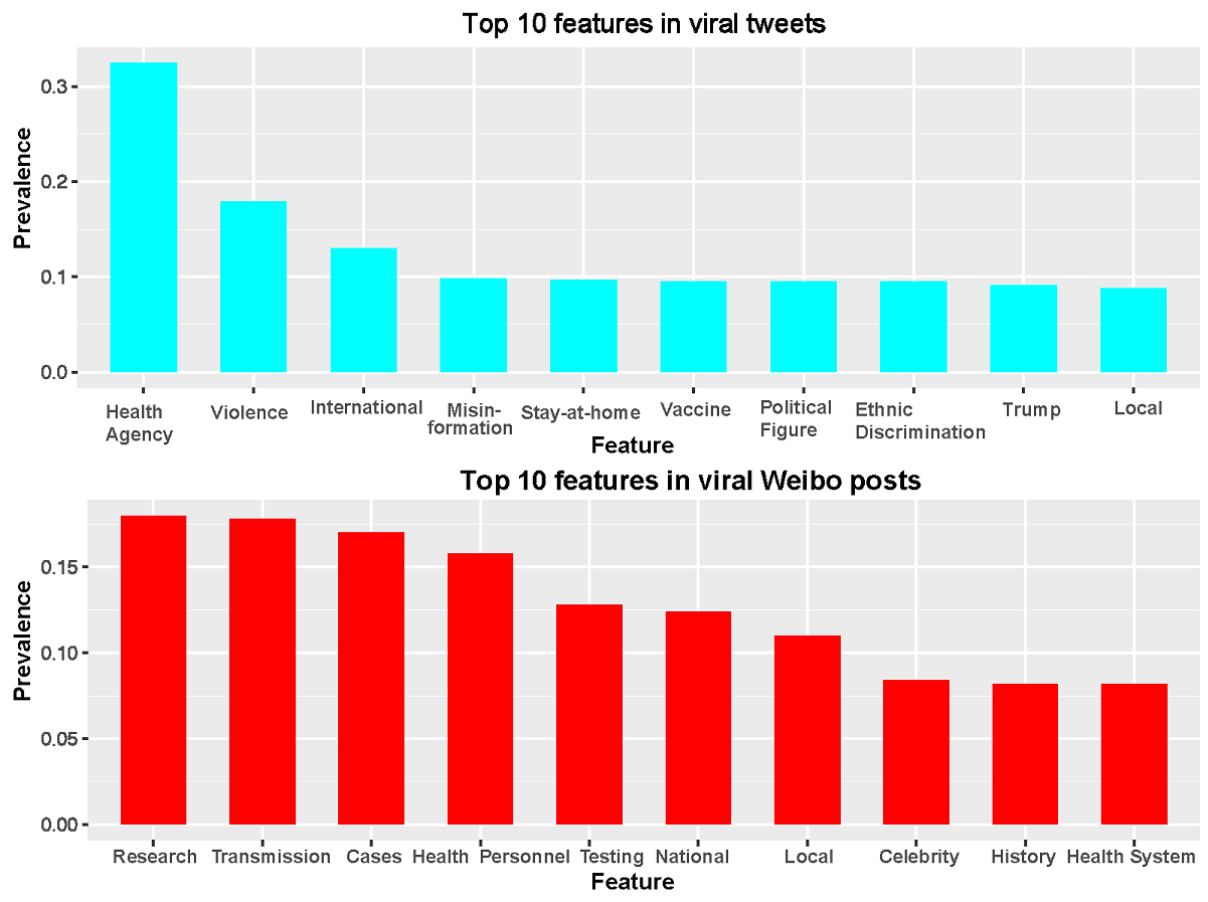
Figure 2. Top 10 content features and their prevalence on Twitter (top) and Weibo